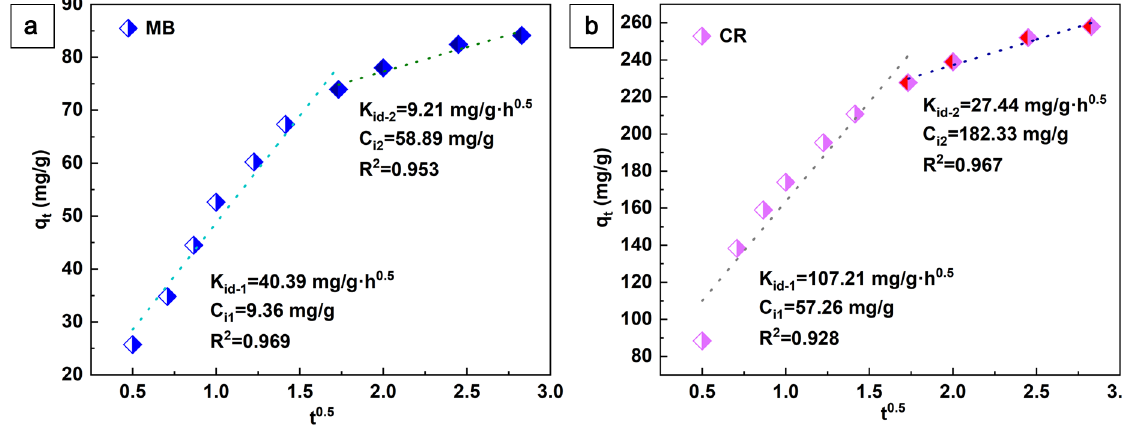
Figure 7. The linear dependence of q t on t 0.5 based on the intra-particle diffusion, MB ( a ) and CR ( b ).